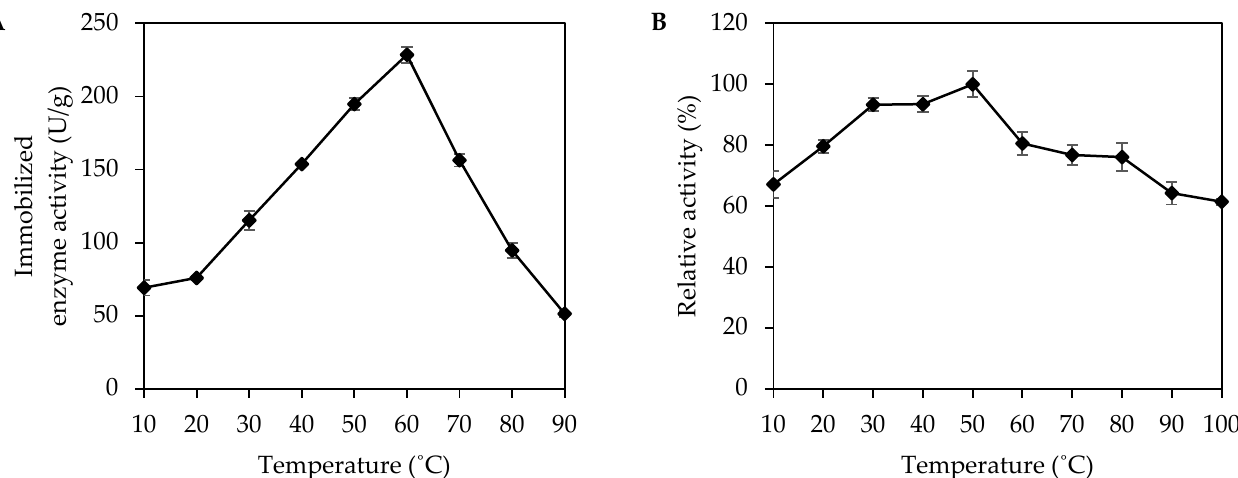
Figure 3. Characterization of immobilized carboxylic acid reductase from Mycobacterium phlei ( Mp CAR). The effect of temperature on the activity ( A ) and stability ( B ) of the immobilized Mp CAR. The optimal temperature and thermal stability of immobilized Mp CAR were measured at different temperatures ranging from 10 to 90 ◦ C and from 10 to 100 ◦ C, respectively. Samples were measured in tripli- cates.